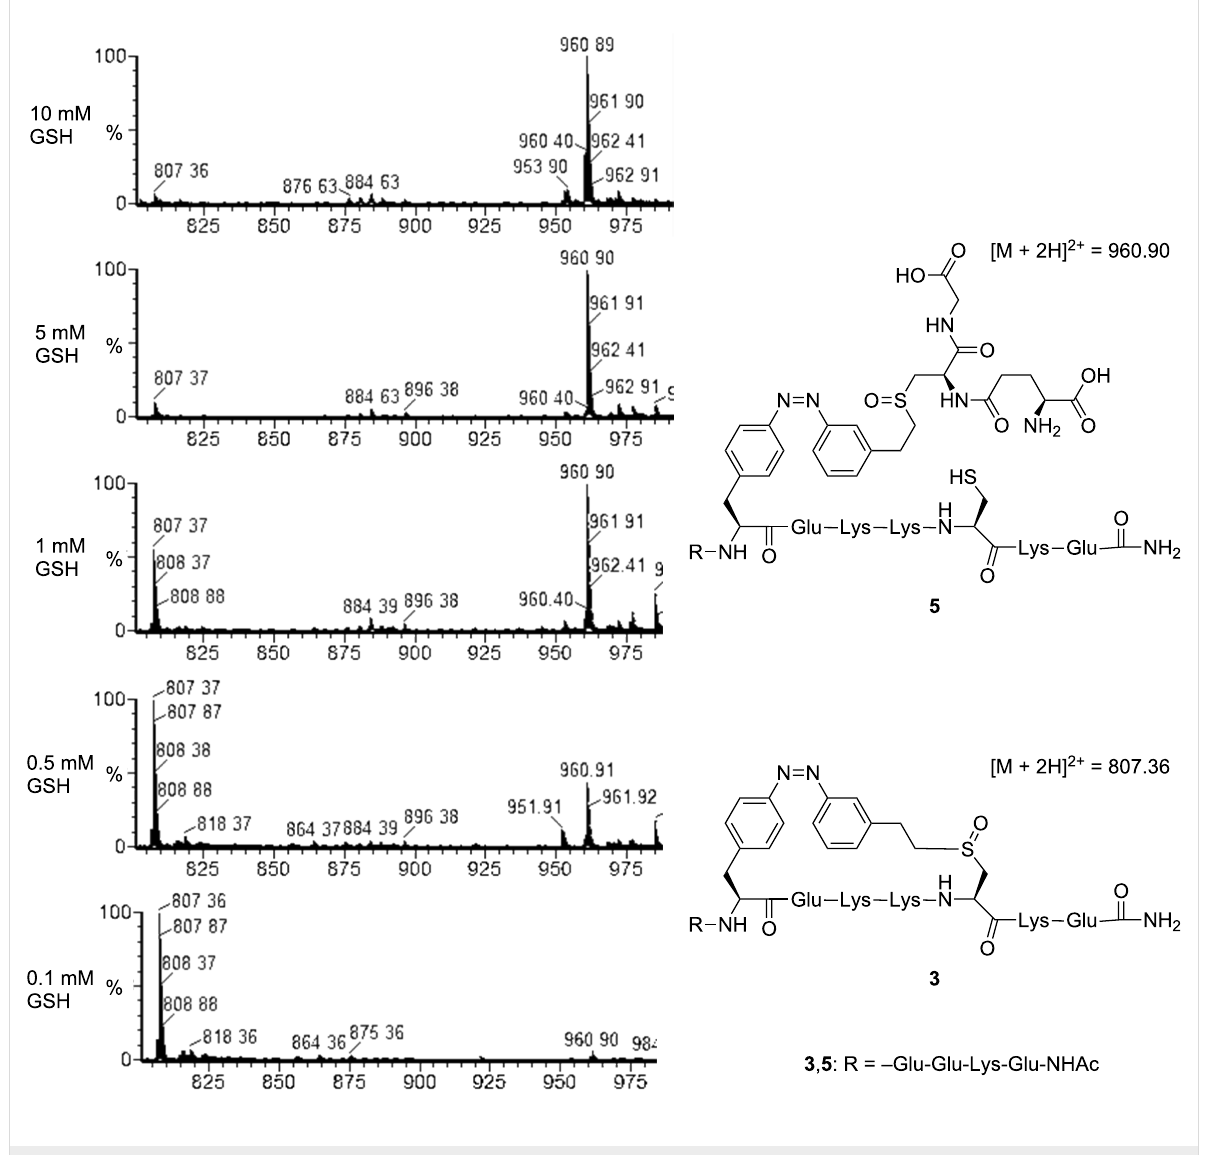
Figure 2: ESI–MS spectra of fractions of the crude reaction solution of the thiol–ene click reaction of peptide 1 (peptide concentration 0.1 mM) in the presence of GSH (10 mM, 5 mM, 1 mM, 0.5 mM, 0.1 mM), showing the intermolecular click product 5 at high GSH concentrations and the intramolec- ular click product 3 at decreasing GSH